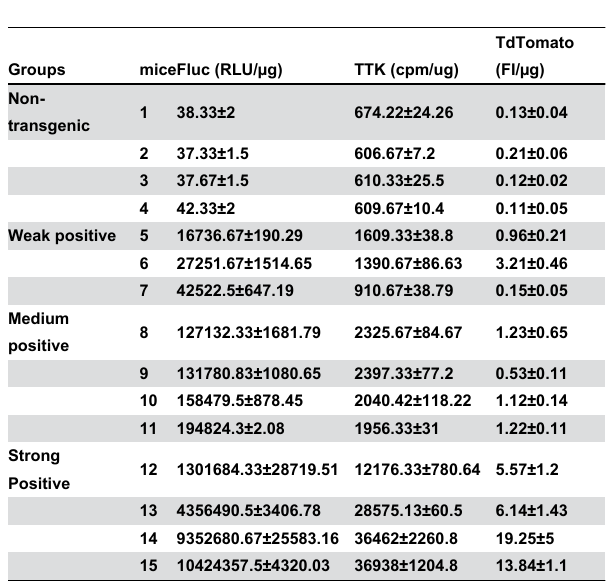
Table 1. Reporter gene expression levels in transgenic